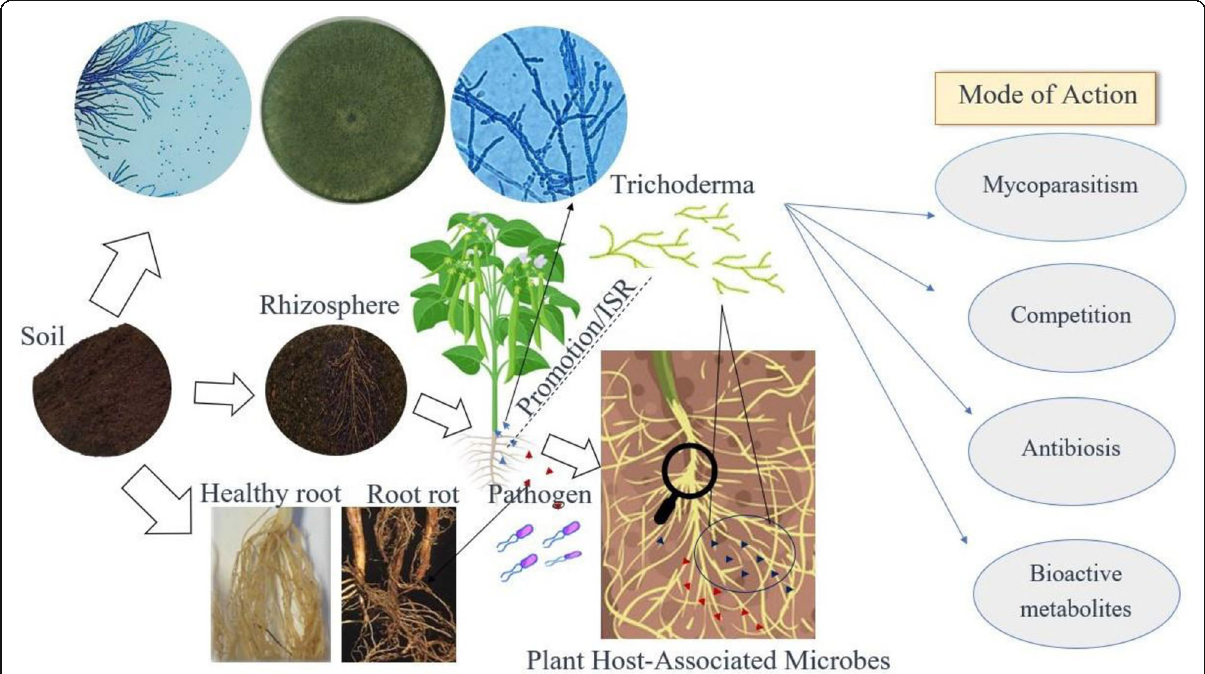
Fig. 1 Initial steps of the interaction between the root rot pathogen and the biocontrol agent Trichoderma in soil . When Trichoderma is surrounding the rhizosphere (green hyphae), it associates with the plant roots to protect them from the invasion of pathogens by mycoparasite or colonizing the roots and improve the plant health by induced systemic resistance